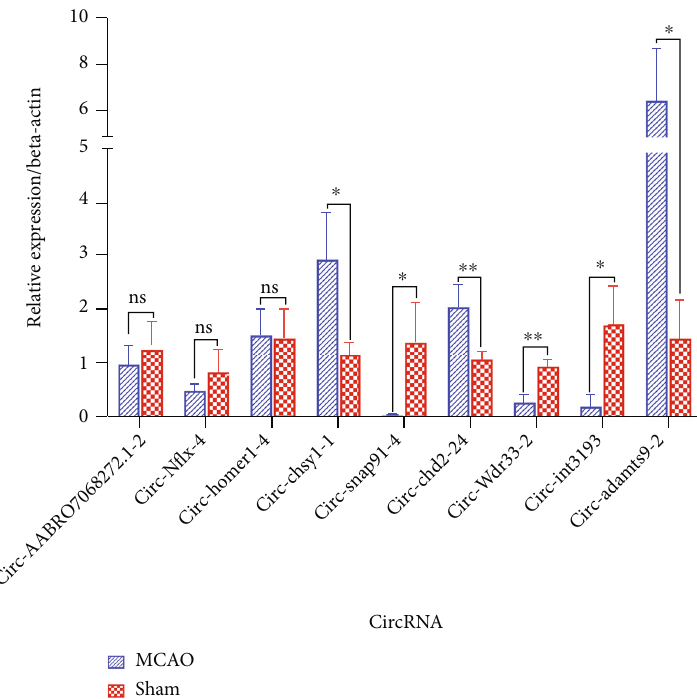
Figure 4: Quantitative real-time PCR (qPCR) validation of nine randomly selected circular RNAs. Nine circRNAs with nonsigni fi cantly or signi fi cantly di ff erent expression patterns between the two groups as assessed by RNA-seq were selected. Expression patterns of circRNAs were veri fi ed using qPCR, which were consistent with the sequencing data. Data are presented as the means ± SEMs ( n = 3 ). ∗ P < 0 : 05 and ∗∗ p < 0 : 01 ; two-tailed paired t